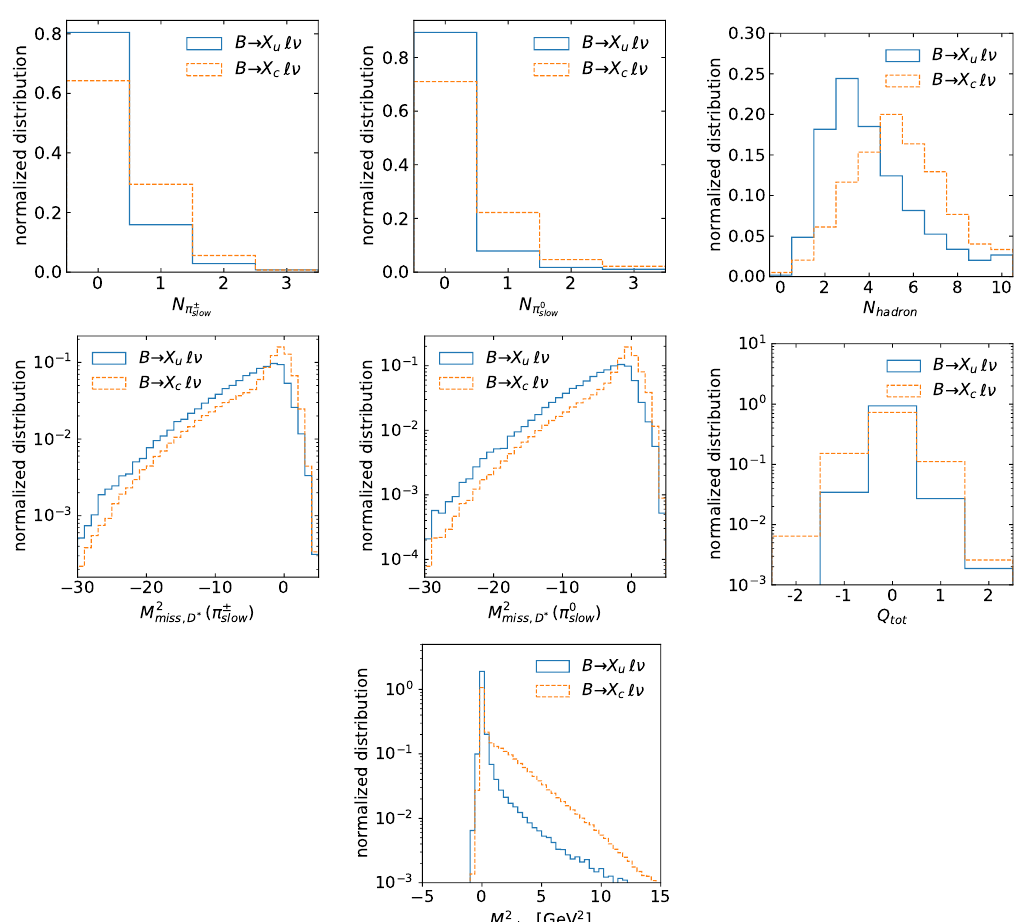
Figure 12 . Comparison of high-level features for B → X u ‘ν signal and B → X c ‘ν background